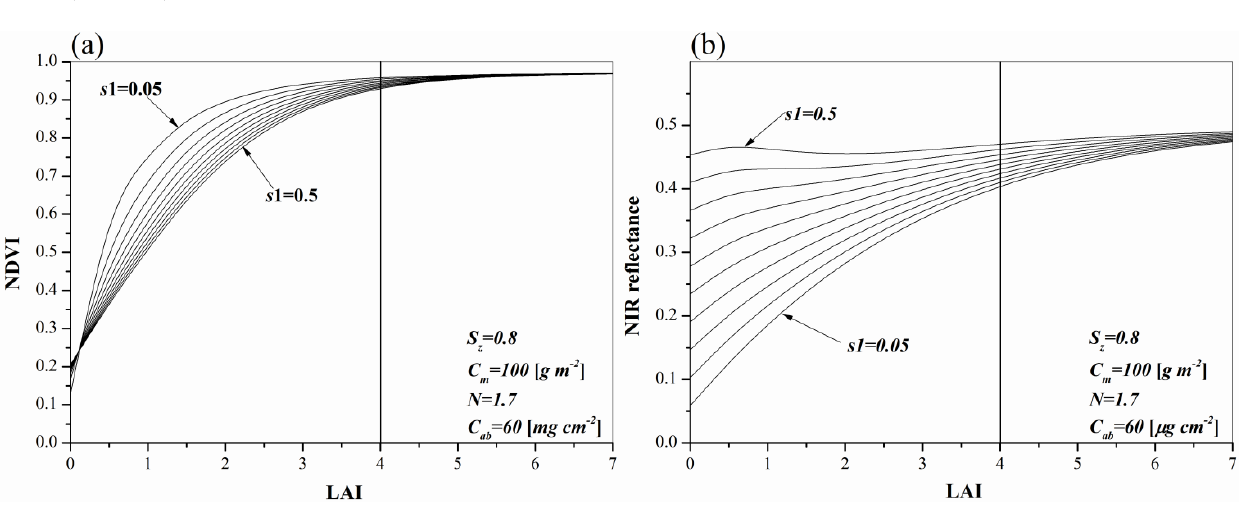
Figure 1. Sensitivity of normalized difference vegetation index (NDVI) to leaf area index (LAI) ( a ) and of NIR reflectance to LAI ( b ) by running two-layer canopy reflectance model (ACRM) forward at different values of s1